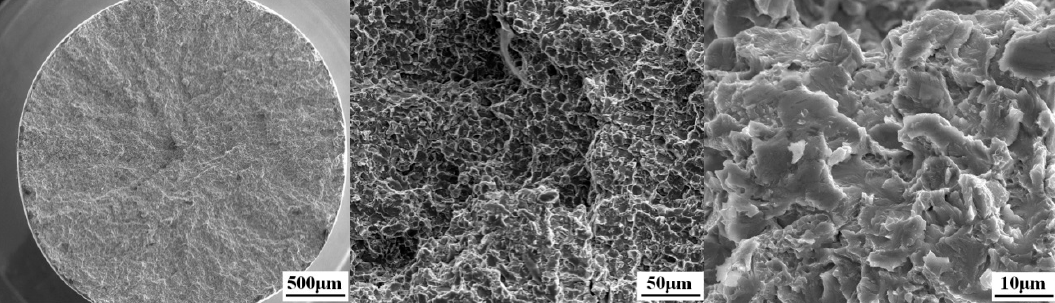
Figure 12. Tensile fracture morphology of the Ti 3 Al LFW joint at room temperature.